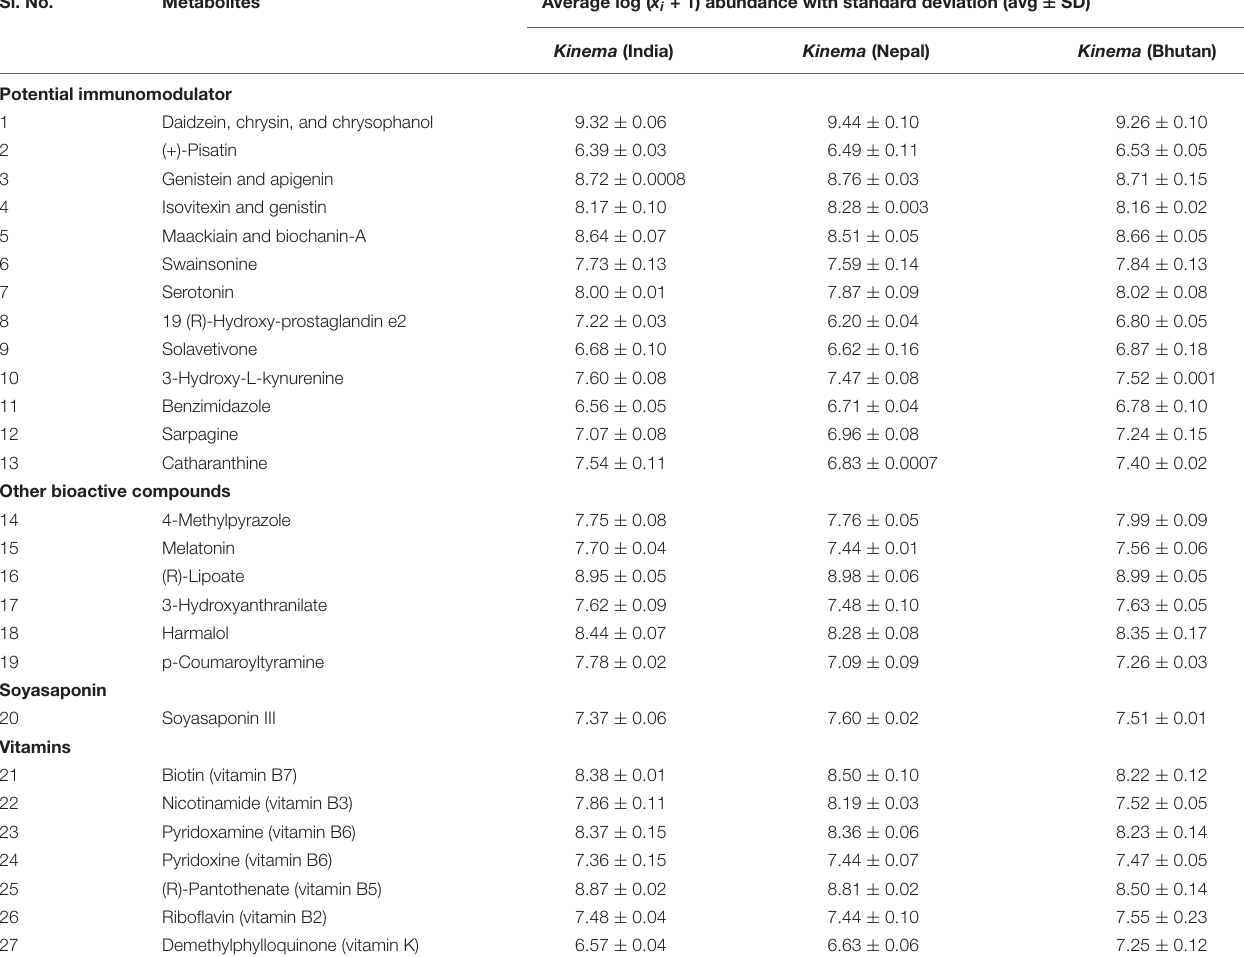
TABLE 2 | Metabolites with potential immunomodulatory effects, other bioactive compounds, soyasaponin, and vitamins ( p < 0.05). Sl.